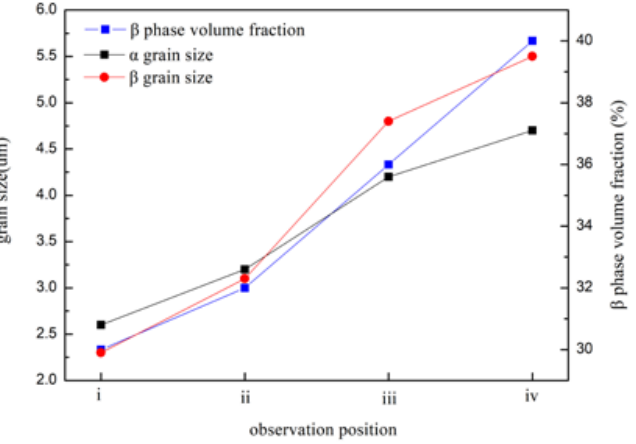
Figure 6. The phase grain sizes and β phase volume fraction at various tensile test positions.